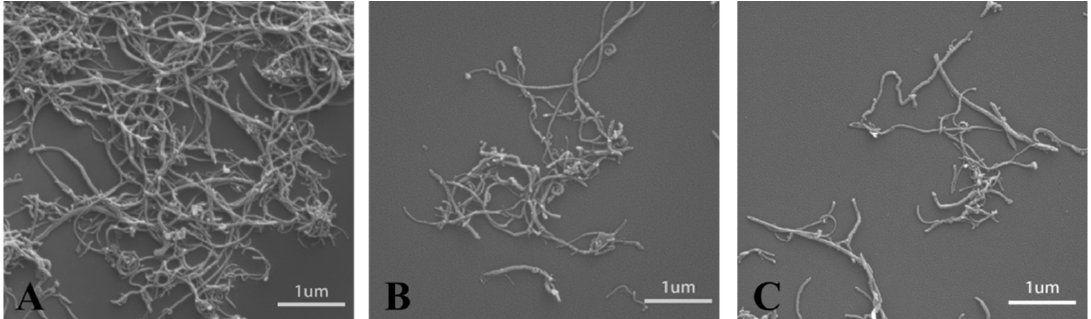
Figure 4. SEM images of CNT ( A ), CNT@PDA ( B ) and CNT@ALG ( C ).